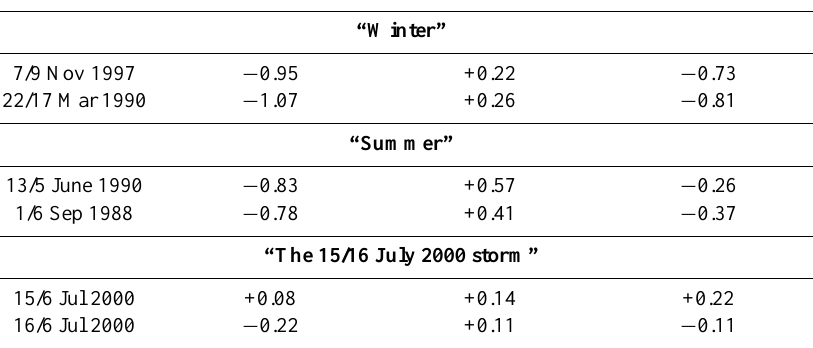
Table 5. Differences at 180km (disturbed-quiet) in atomic and molecular ion concentrations as well as in Ne for “winter” and “summer” disturbances